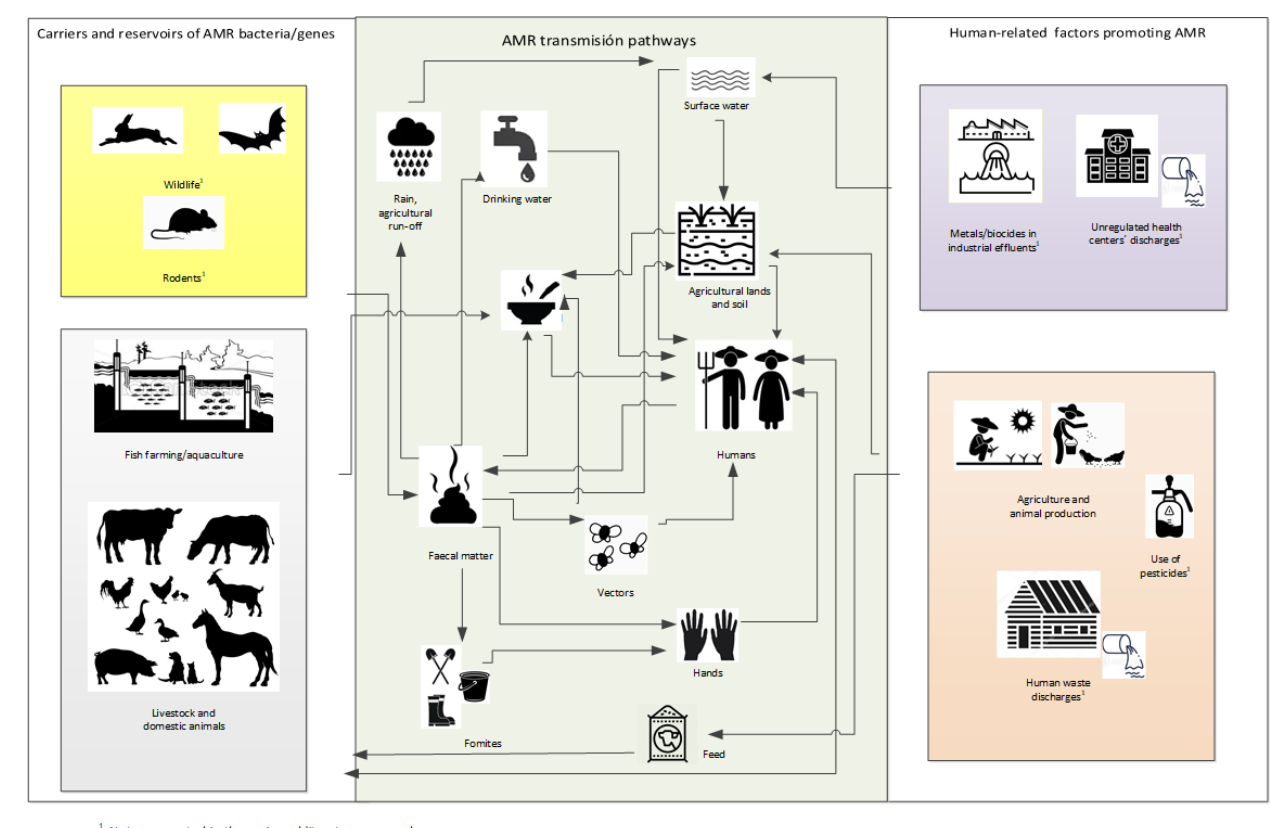
Figure 2. Proposed pathways for the spread of antimicrobials and/or AMR genes in rural settings, based on the publications included in the review.